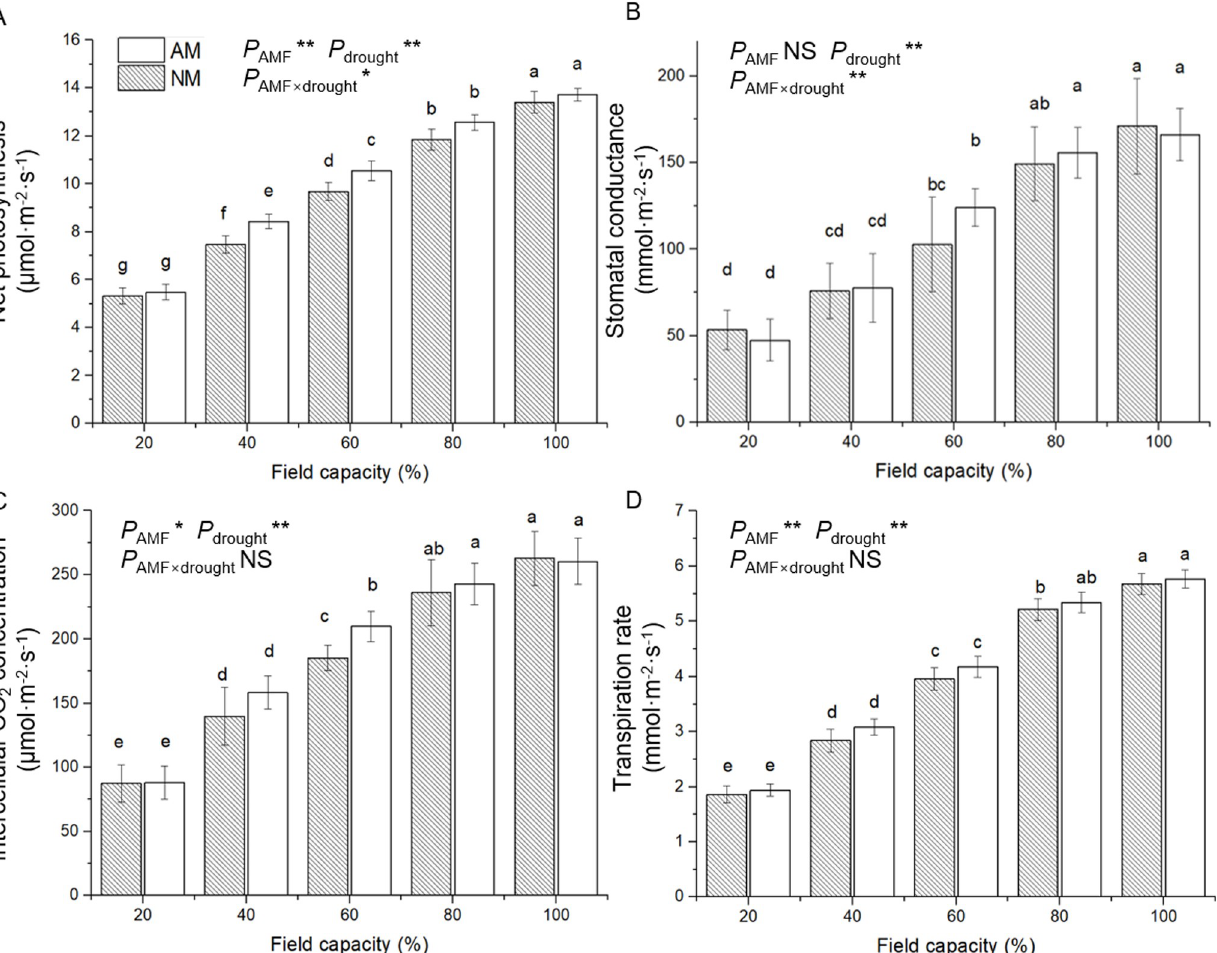
Fig 5. Effect of AM inoculation on gas exchange indexes, Pn (A), Gs (B), Ci (C) and E (D) of E . maackii under water deficit. AM inoculated treatment; NM: uninoculated treatment; AMF: effect of AM inoculation; drought: effect of water deficit; AMF × drought: effect of interaction of AM inoculation and water deficit treatment; NS: no significant effect; � : P � 0.05; �� : P � 0.01. Means with a letter in common within each variable can’t be considered different at P � 0.05.